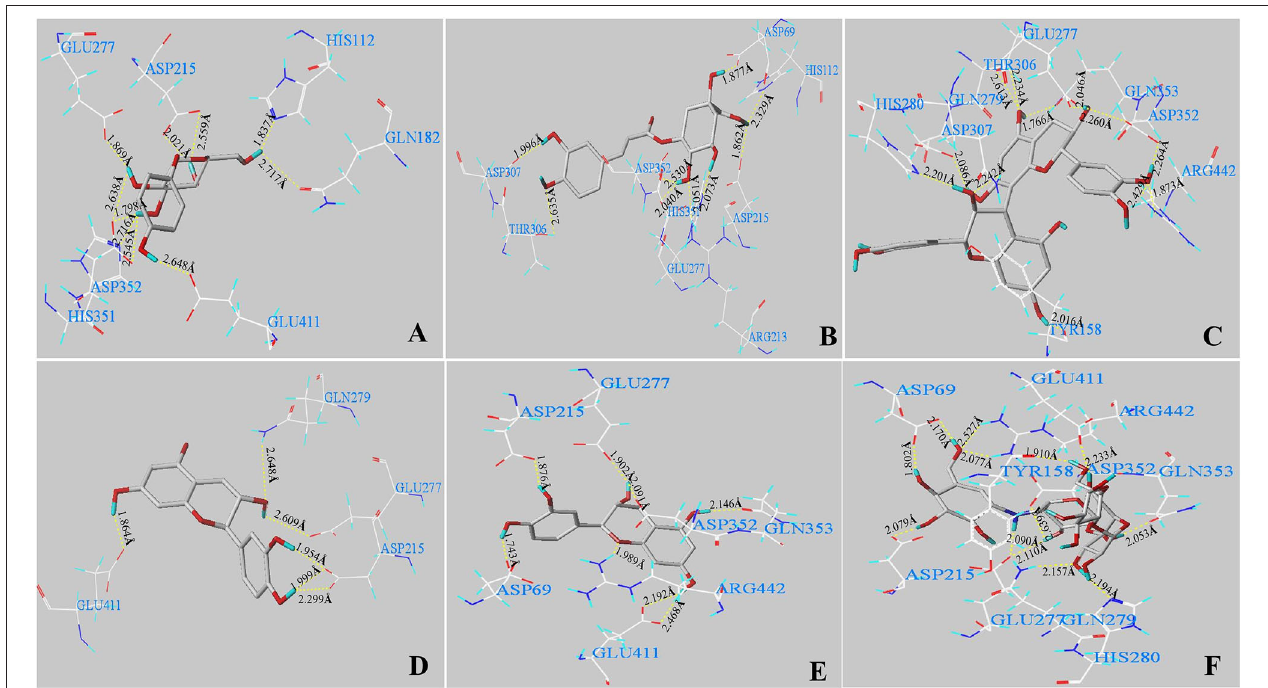
FIGURE 4 | In silico analysis of the main phenolics/acarbose with α -glucosidase. The conformations of five main phenolics and acarbose interacting with amino acid residues in the active site of α -glucosidase: arbutin (A) , chlorogenic acid (B) , procyanidin B1 (C) , ( + )-catechin (D) , (–)-epicatechin (E), and acarbose (F) with residues in the active sites of the α -glucosidase, respectively. The dashed line represents hydrogen bonds.